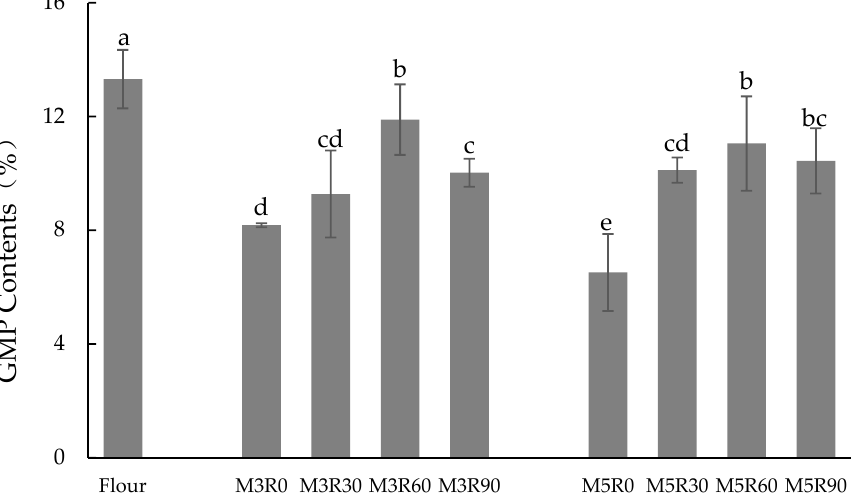
Figure 1. Changes in glutenin macropolymer (GMP) contents (%, expressed as percent GMP in crude protein content of flour). Flour: wheat flour without mixing or resting. M3R0–M3R90: mixing for 3 min and resting for 0, 30, 60, and 90 min, respectively. M5R0–M5R90: mixing for 5 min and resting for 0, 30, 60, and 90 min, respectively. Data are mean values ± standard variation of three replications and different letters indicate a significant difference at p < 0.05.